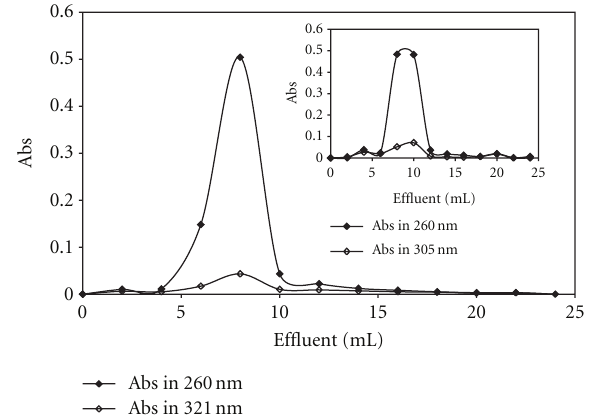
Figure 9: Gel chromatograms of [Pt(bpy)(Oct-dtc)]NO 3 and the inset for [Pd(bpy)(Oct-dtc)]NO 3 obtained on Sephadex G-25